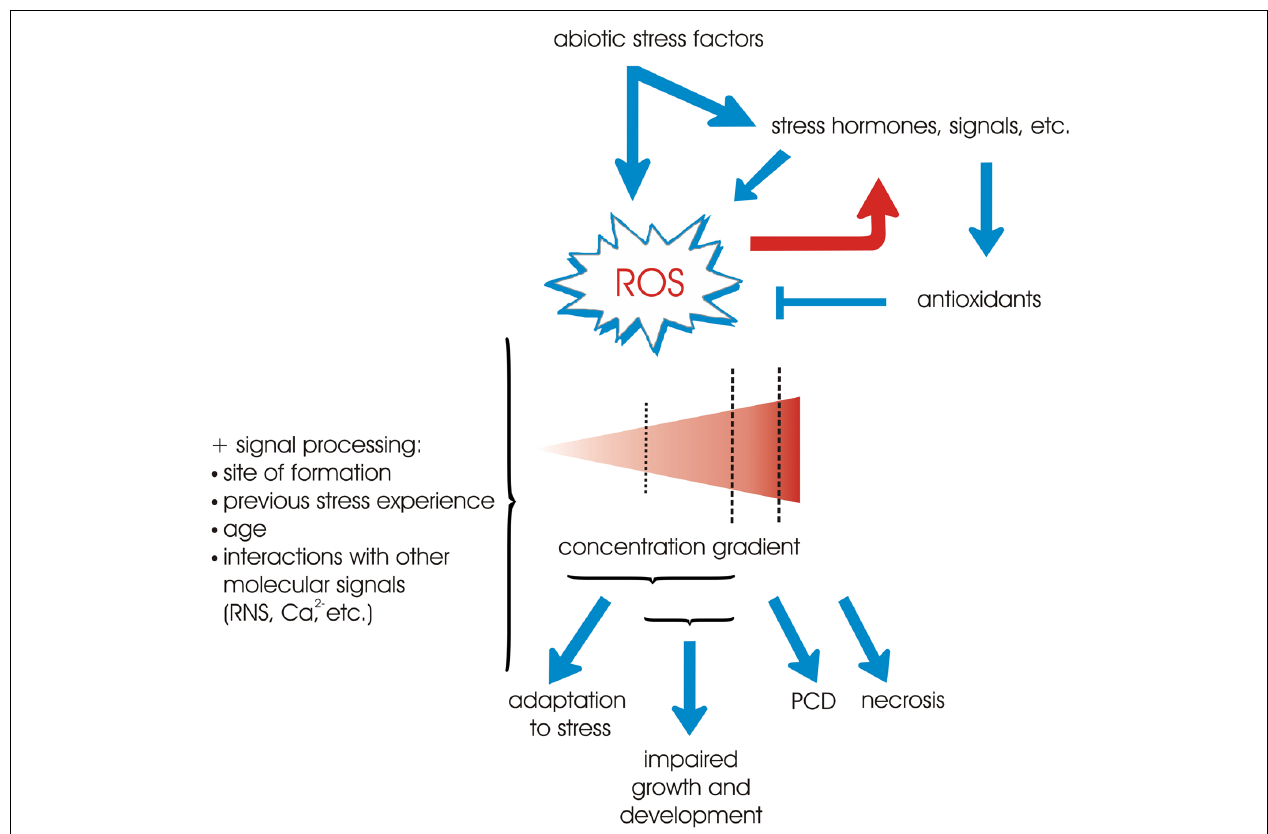
ROS synthesis, previous stress exposure, developmental stage, and interaction with other signals like reactive nitrogen species (RNS) and Ca 2 + are also integrated into the response. In general relatively weak stressors cause only a slight rise in ROS quantities which leads to adaptation. At more intensive abiotic stimuli the price for adaptation may be impaired growth and development of the plant. Severe stress usually causes massive accumulation of ROS and the initiation of PCD, or in extreme cases even necrosis of the